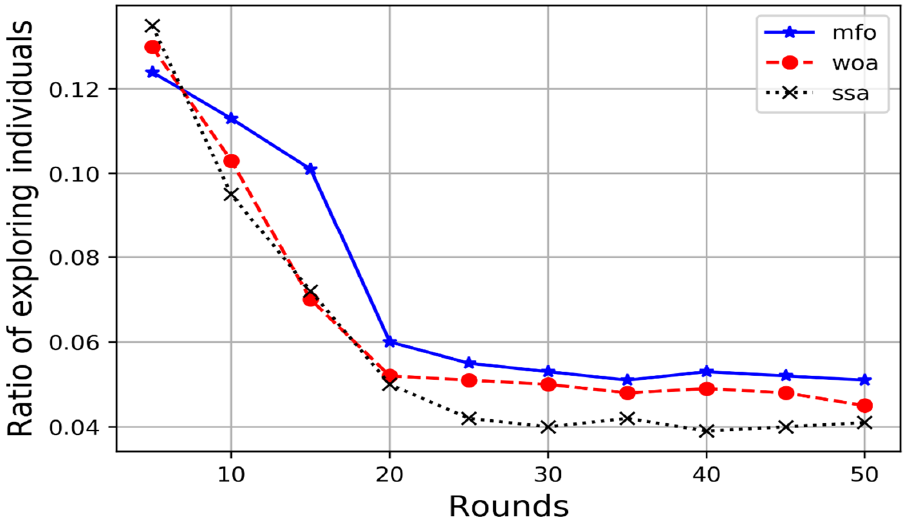
Figure 2. Ratio of individuals exploring the search space.